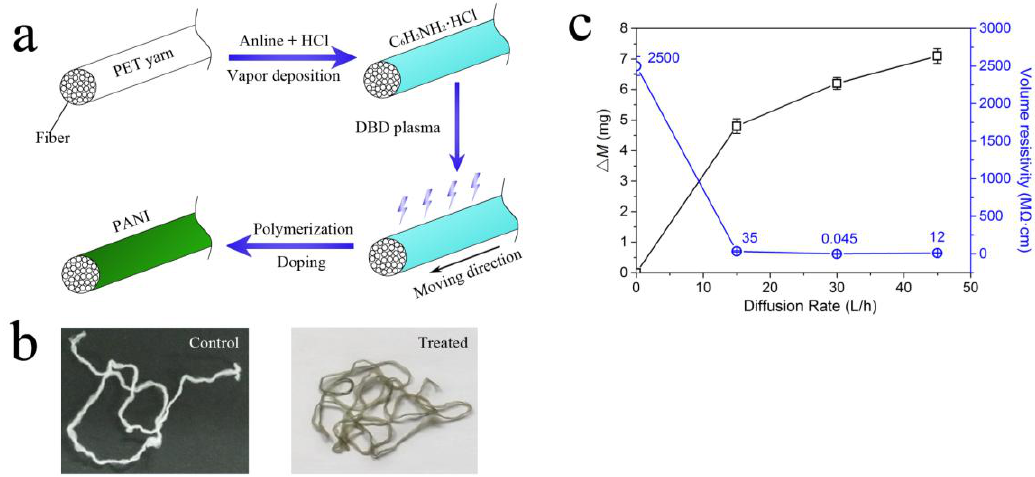
Figure 3. ( a ) Illustration of the treatment procedure; ( b ) chemical structures of idealized oxidation states of PANI; ( c ) the effect of coating amount (Δ M ) of PANI on volume resistivity of PET yarns.